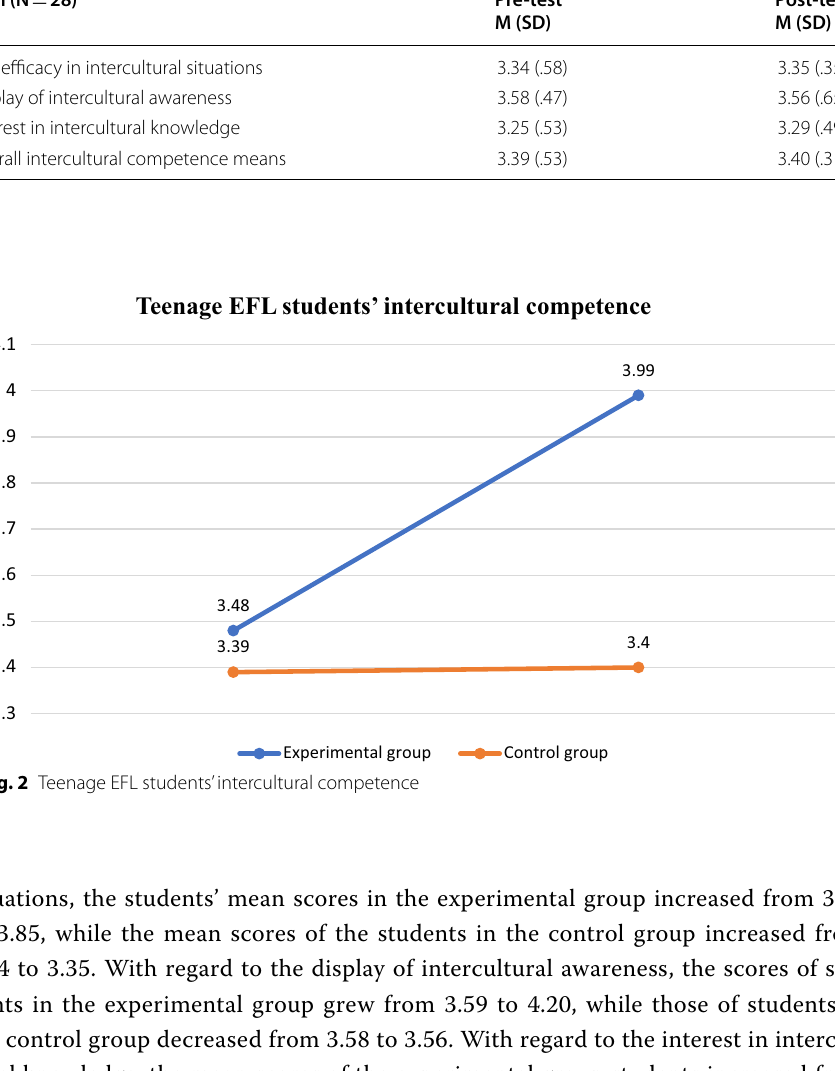
Table 10 Intercultural competence rating scale (control group) Item (N 28) =